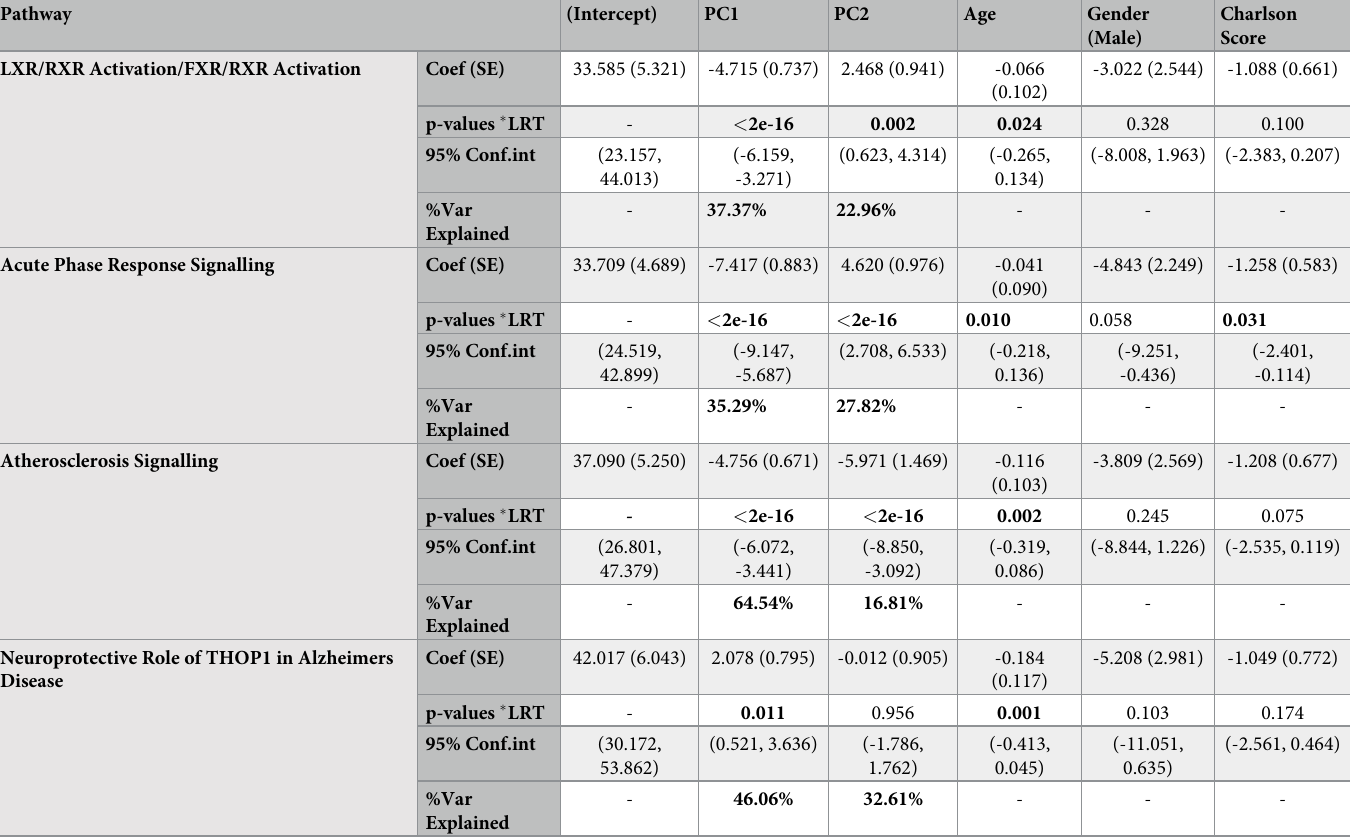
Table 10. Regression models for proteins associated with COVID-19 severity (all patients).